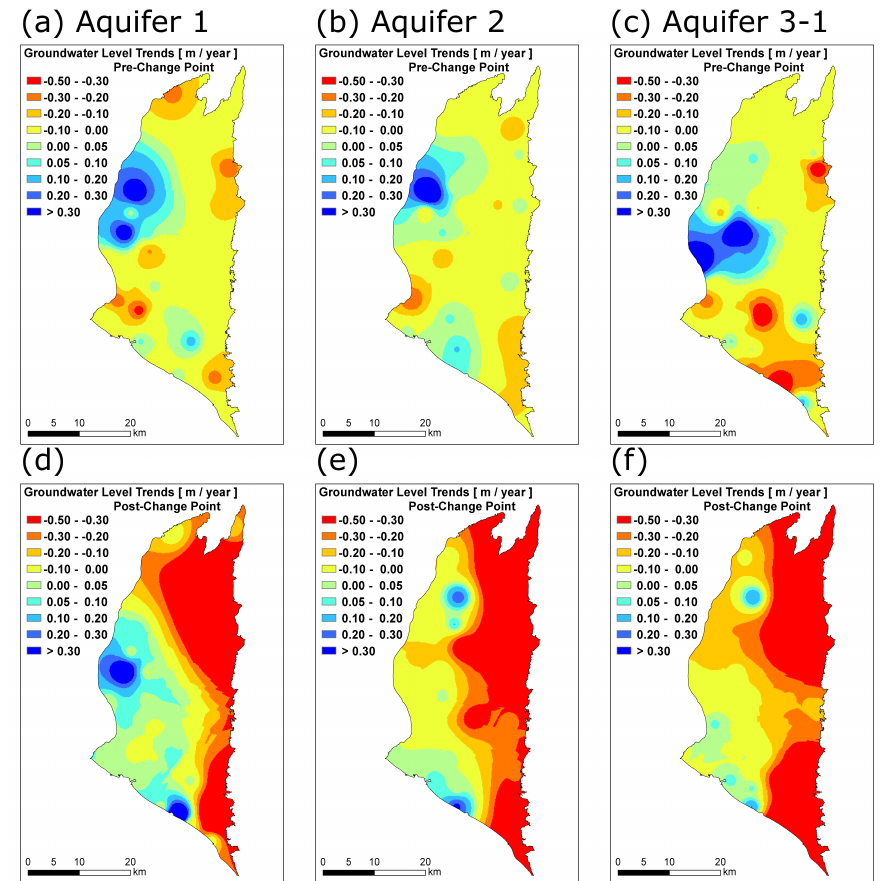
Figure 7. The ( top ) and ( bottom ) panel shows the estimated trends in groundwater levels prior (posterior) to the identified change points at each gauge.